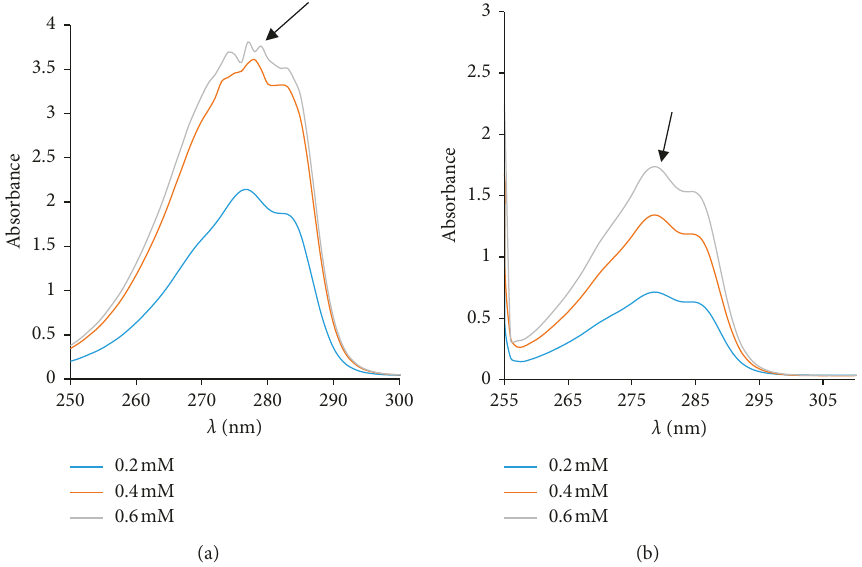
Figure 3: UV absorption spectra of 2-chlorophenol in (a) methanol and (b) DMSO with arrows indicating the λ